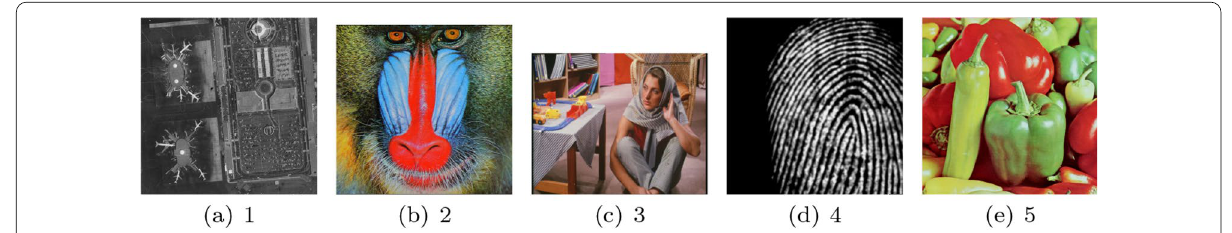
Fig. 5 Some of the test images used in our experiment